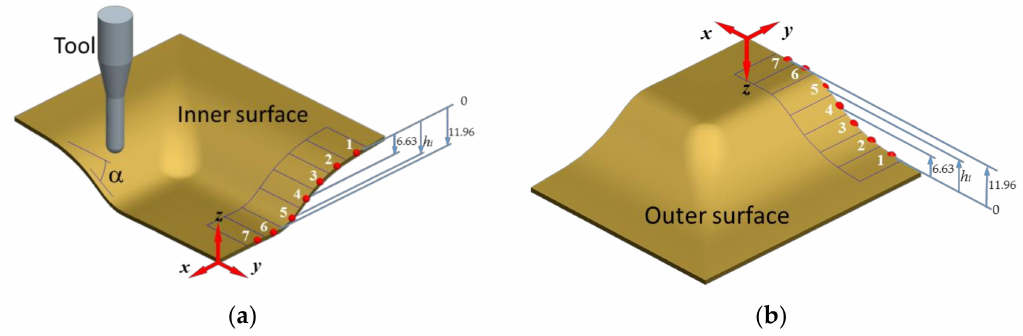
Figure 4. Points on the sample surface at which residual stresses were estimated by XRD technique for ( a ) the inner surface, and ( b ) the outer